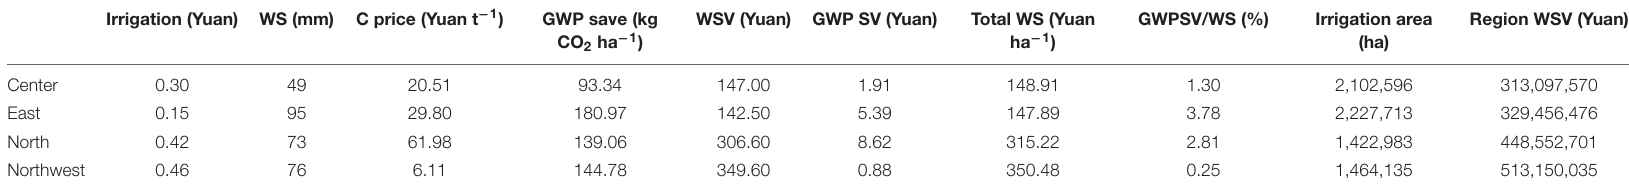
Center North Northwest